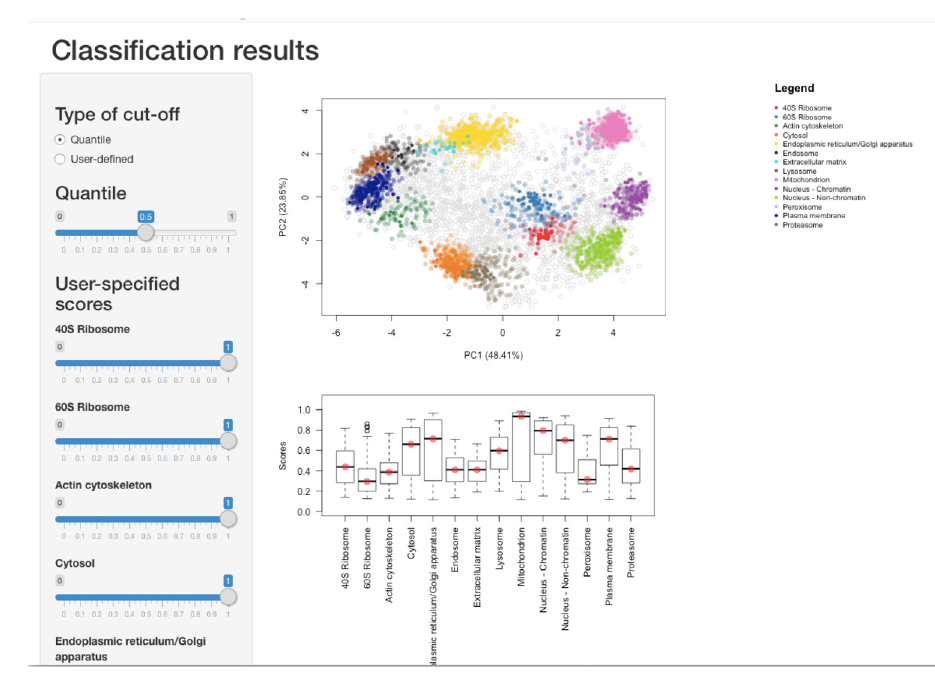
Figure 19. The classify application enable the interactive exploration of classification score thresholding.